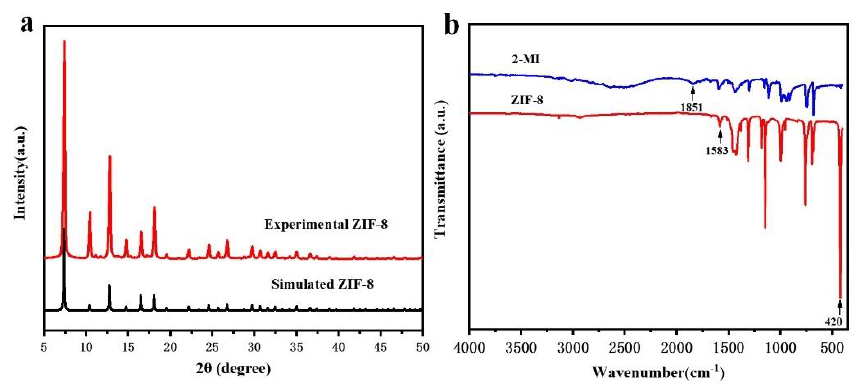
Figure 2. ( a ) XRD patterns of ZIF-8, ( b ) FT-IR spectrum of ZIF-8 and